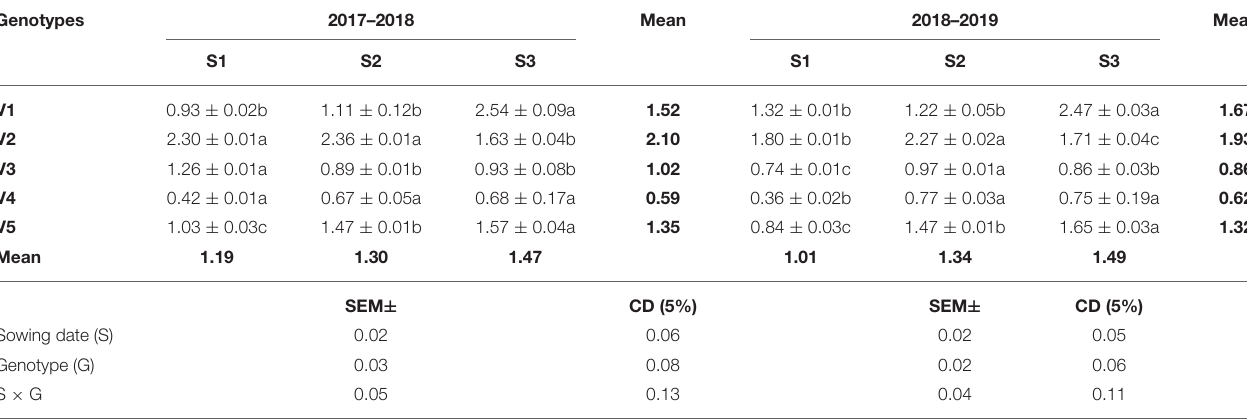
TABLE 2 | Malondialdehyde (MDA) content ( µ mol g − 1 fresh weight) at mid-flowering stage in the top leaf of mustard varieties sown at three different dates during rabi 2017–2018 and 2018–2019.